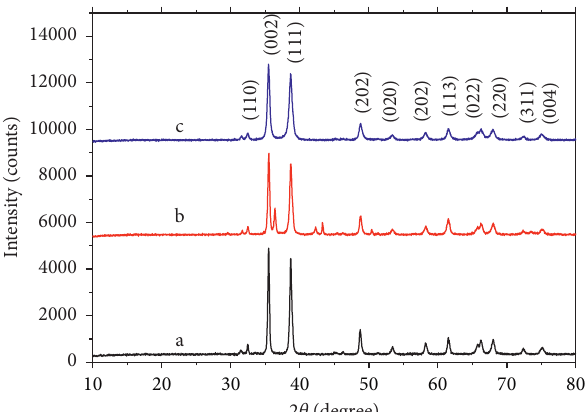
Figure 2: XRD patterns of CuO NPs synthesized using copper (II) nitrate trihydrate and Catha edulis leaf extract of different ratios (w/v): (a) 1:10, (b) 3 :10, and (c)